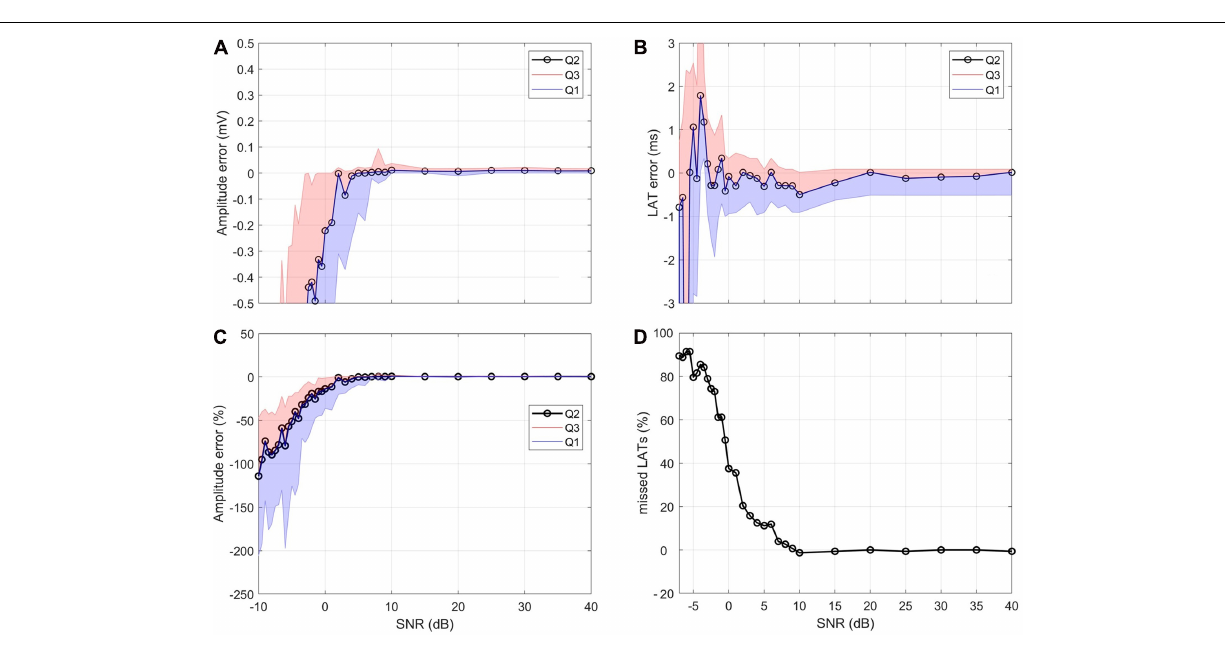
FIGURE 6 | Influence of noise. (A) Median (Q2) amplitude error and interquartile distance (Q1, Q3). (B) Median LAT error and interquartile distance. (C) Relative amplitude error with respect to true amplitude. (D) Percentage of missed LAT detections. For (A,B) the y -axis was capped for visualization